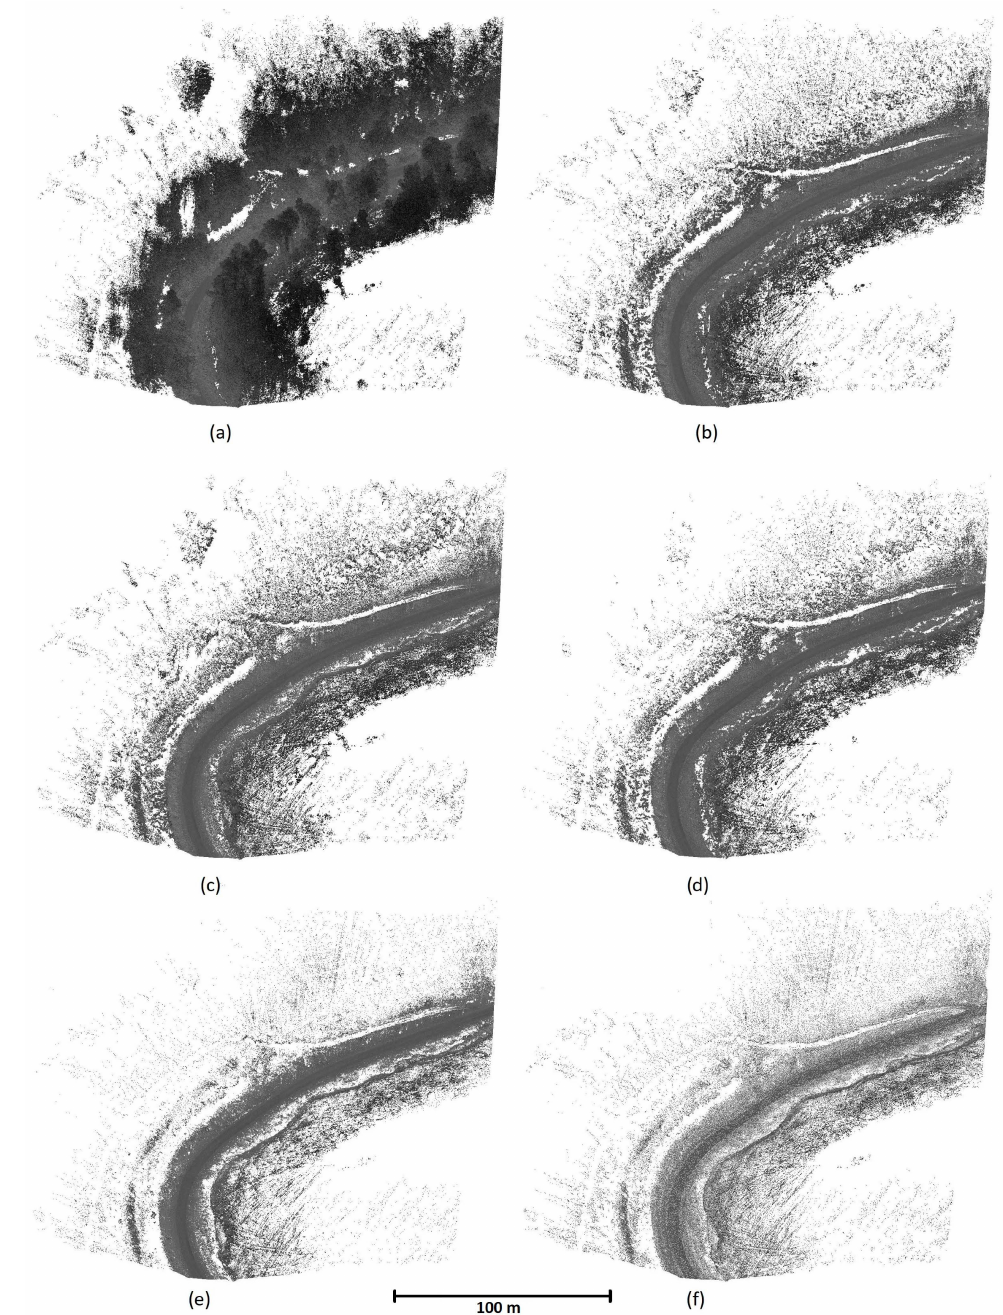
Figure A3. Results of filtering of site 2: ( a ) original data, ( b ) after PMF filtering, ( c ) after SMRF filtering, ( d ) after CSF filtering, ( e ) after ATIN filtering, and ( f ) after MDSR